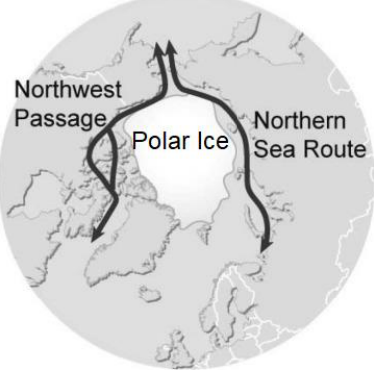
Figure 1. The Northern Sea Route and the Northwest Passage.